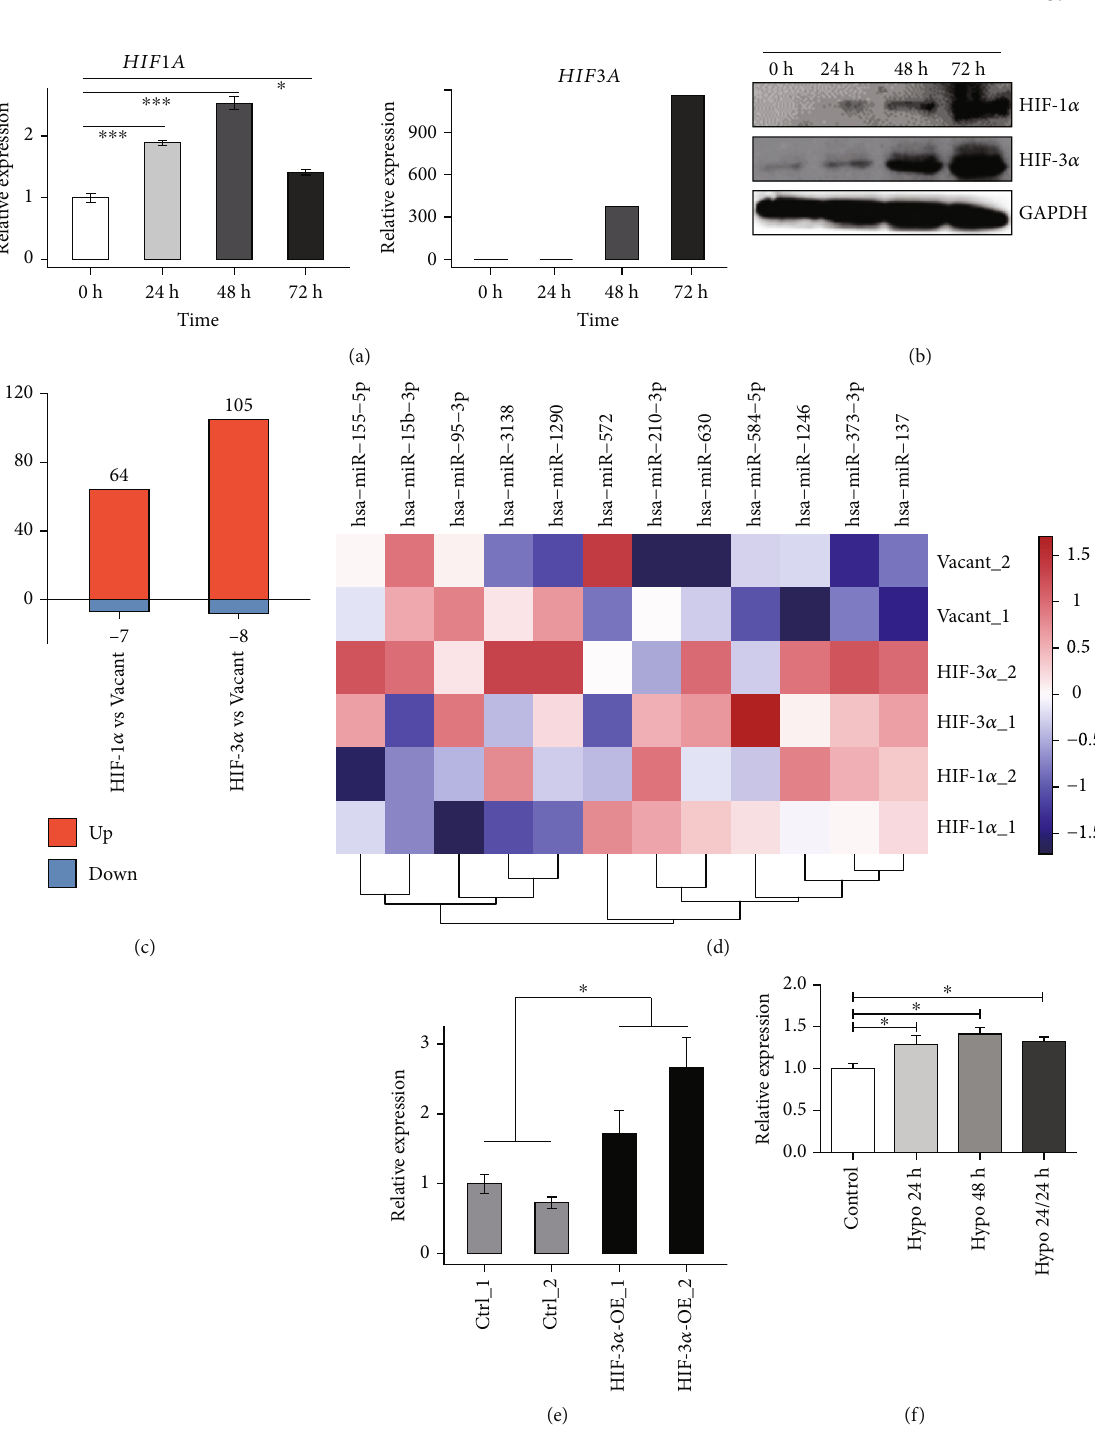
Figure 1: HIF-1 α and HIF-3 α promote miR-630 expression under hypoxia. (a) Bar plot showed the increased RNA level of HIF1A and HIF3A under hypoxia by RT-qPCR experiment. (b) Western blot result showed the increased protein level of HIF1A and HIF3A under hypoxia. (c) Bar plot showed the DEmiR number in HIF-1 α vs. in the vacant group and in HIF-3 α vs. in the vacant group. (d) Hierarchical clustering heat map showed the elevated expression level of selected miRNAs in HIF-1 α and HIF-3 α OE samples. (e) Bar plot showed the increased expression level of miR-630 under hypoxia by RT-qPCR experiment. (f) Bar plot showed the expression level of miR-630 under hypoxia by RT-qPCR